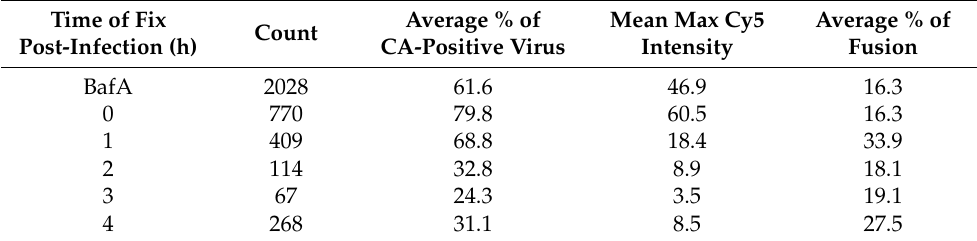
Table 1. In situ uncoating data from two independent